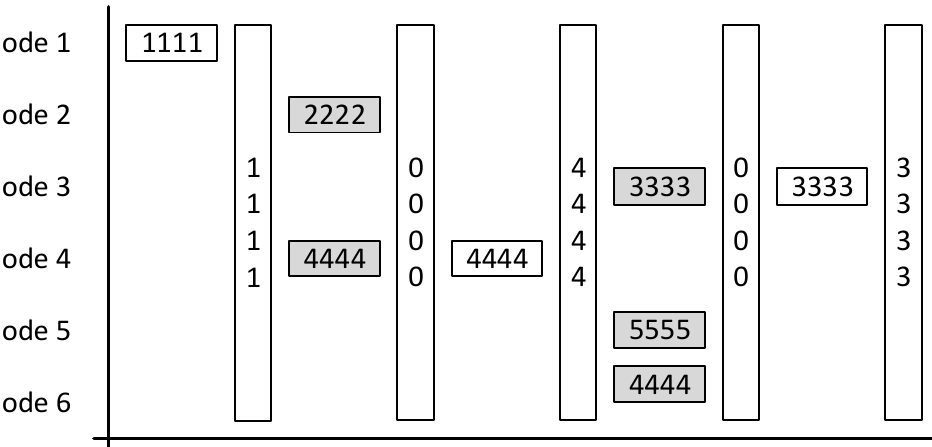
Figure 7. Diagram demonstrating a network using the slotted ALOHA with beacons with grey boxes indicating collisions and overlapping. White boxes indicate successful communication.